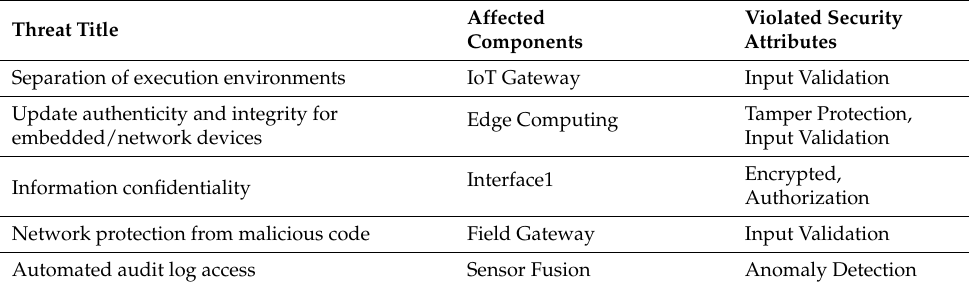
Table 3. Some selected potential threats identified by THREATGET.